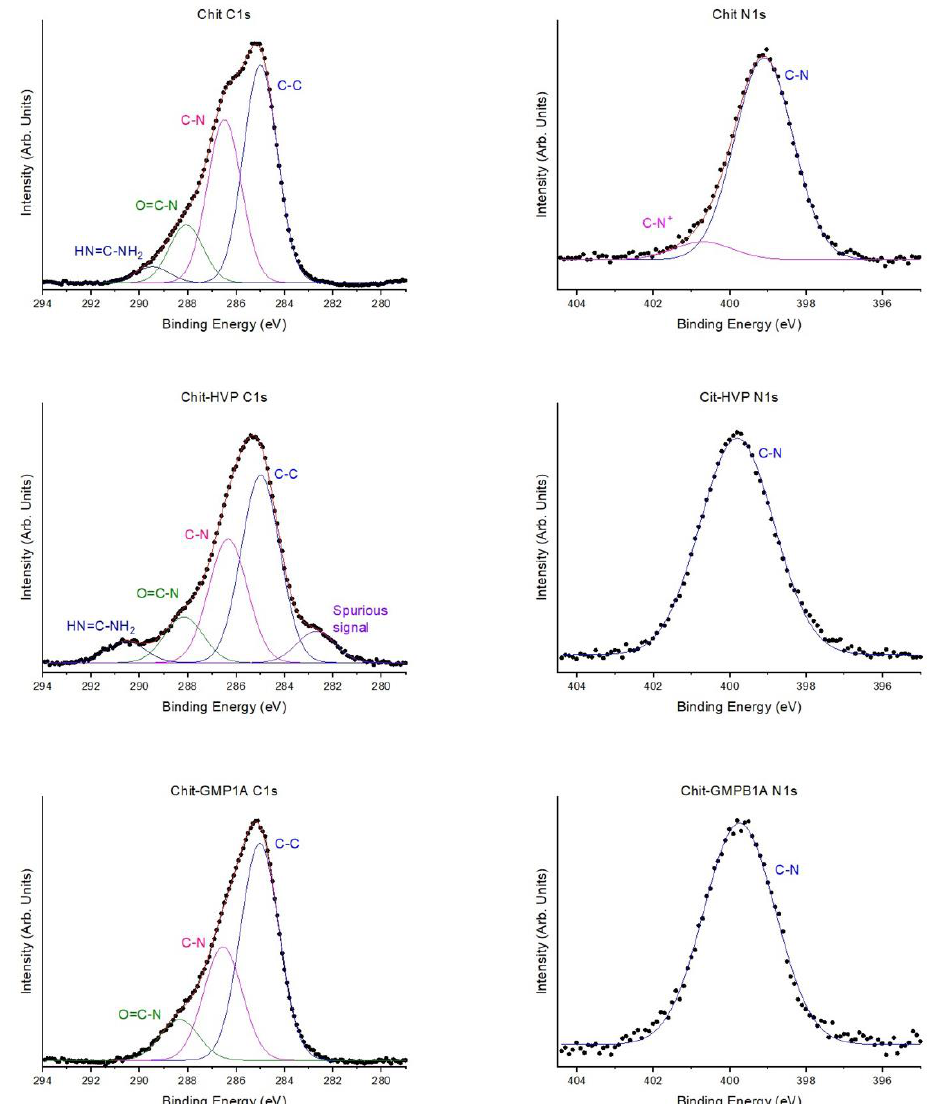
Figure 2. C1s and N1s experimental spectra of Chit, Chit-HVP, and Chit-GBMP1a deposited on gold with curve-fitting analysis. Markers represent experimental points; lines represent fitting components and calculated spectra.